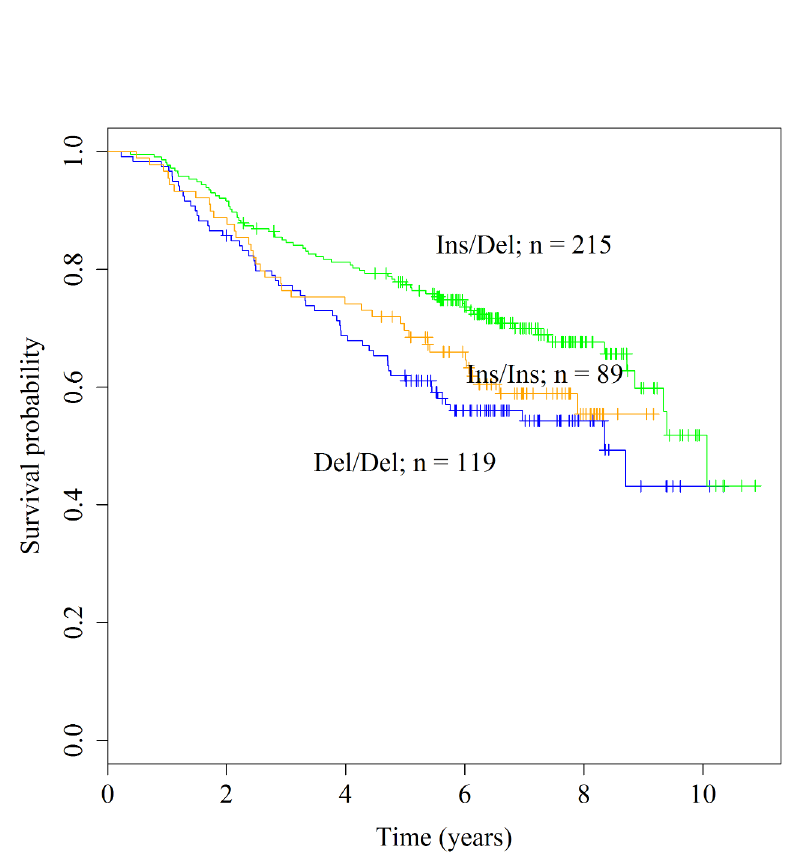
Fig 1. Kaplan-Meier curves for the BRM -741indel under the co-dominant genetic model in the colorectal cancer cases. P value of the log-rank test is 0.017.